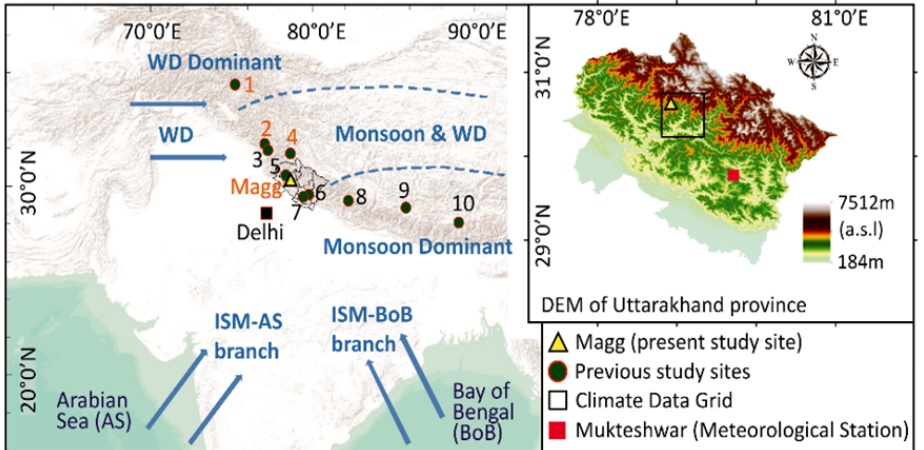
Figure 1. Location of the present study site and the sites of previous δ 18 O studies from the Indian Hi- malayas and adjacent regions. (1) Karakoram Pakistan [47]. (2) Keylong, Lahaul-Spiti [49]. (3) Manali, HP [33]. (4) Zhada, Tibet [41]. (5) Din Gad Valley, Uttarakhand [46]. (6) Mukteshwar (meteoro- logical station), Uttarakhand. (7) Jageshwar, Uttarakhand [33]. (8) Jumla, Nepal [45]. (9) Ganesh, Nepal [33]. (10) Bhutan [44]. Sites with orange numbers (1,2,4) and Magg captured temperature and moisture signals for winter-spring months. Sites with black numbers captured moisture signals for summer monsoon months. Monsoon boundaries (ISM = Indian Summer Monsoon; WD = Westerly Disturbance) in blue dashed lines after Huang et al.